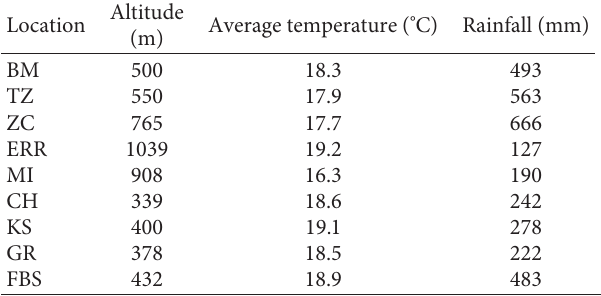
Table 1: Geographical data of Picholine olive oil collection sites. Altitude Location